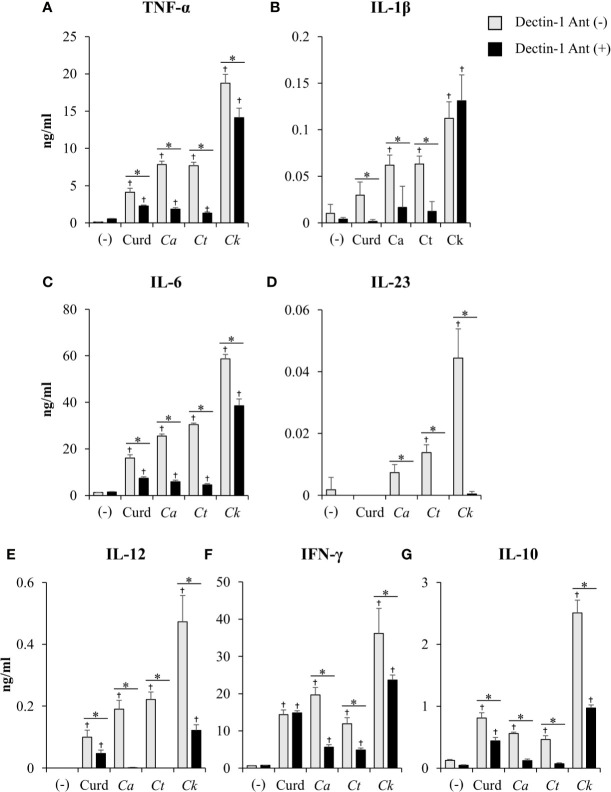
Contribution of dectin-1 blockade to dendritic cell (DC) cytokine production. Bone-marrow derived DCs (BMDCs) were pre-treated with 25 µg/ml of dectin-1 antagonist for 2 h, and then the cells were stimulated with 25 µg/ml of curdlan and β-glucans isolated from C. albicans, C. tropicalis, and C. krusei for 24 h. Levels of (A) TNF-α, (B) IL-1β, (C) IL-6, (D) IL-23, (E) IL-12, (F) IFN-γ, and (G) IL-10 were measured in culture supernatants by ELISA. n = 5; data are representative of two independent experiments. †
p<0.05 compared with unstimulated BMDCs, *p<0.05. (-), unstimulated BMDCs; Curd, curdlan; Ca, C. albicans; Ct, C. tropicalis; Ck, C. krusei.